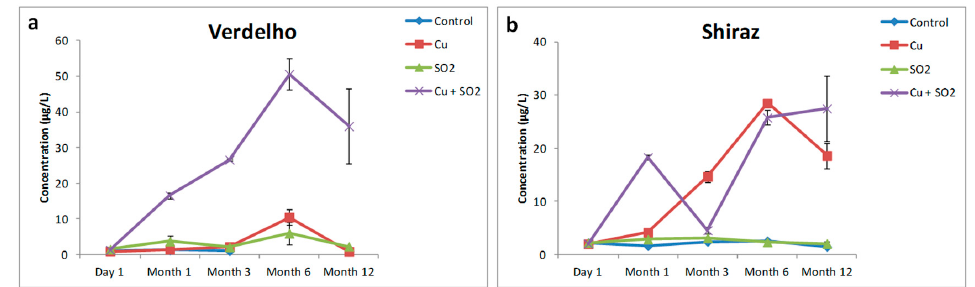
Figure 1. The effects of Cu 2+ , SO 2 , and “Cu 2+ + SO 2 ” on the formation of H 2 S in ( a ) Verdelho and ( b ) Shiraz wine samples that were stored under nitrogen (N 2 ) and measured over the course of 12 months. Table 1. Effects of Cu 2+ , SO 2 , and “Cu 2+ + SO 2 ” treatments on H 2 S formation in Verdelho and Shiraz wine samples.